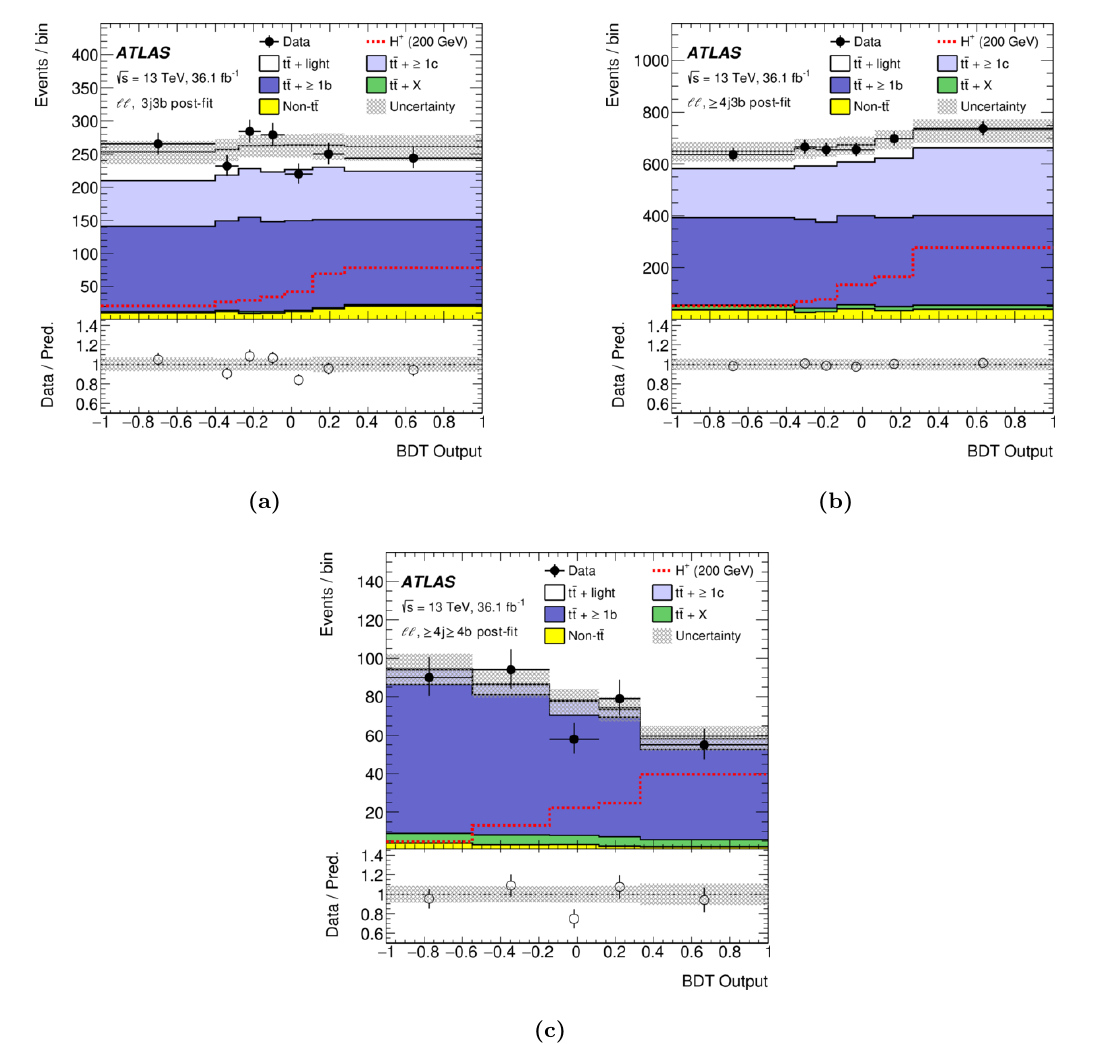
Figure 7. Distributions of the BDT output after the (cid:12)t to the data in the three SRs of the ‘‘ (cid:12)nal state: (a) 3j3b, (b) (cid:21) 4j3b and (c) (cid:21) 4j (cid:21) 4b for the 200 GeV mass hypothesis. Each background process is normalised according to its post-(cid:12)t cross-section. The t (cid:22) t + X includes contributions from t (cid:22) tW , t (cid:22) tZ and t (cid:22) tH . The total prediction of the BDT distributions includes cases where the signal obtained from the (cid:12)t is negative. For this particular mass point the (cid:12)tted signal strength is (cid:22) = (cid:0) 0 : 4 (cid:6) 1 : 5 pb. The pre-(cid:12)t signal distribution is shown superimposed as a dashed line with arbitrary normalisation. The lower panels display the ratio of the data to the total prediction. The hatched bands show the post-(cid:12)t uncertainties.